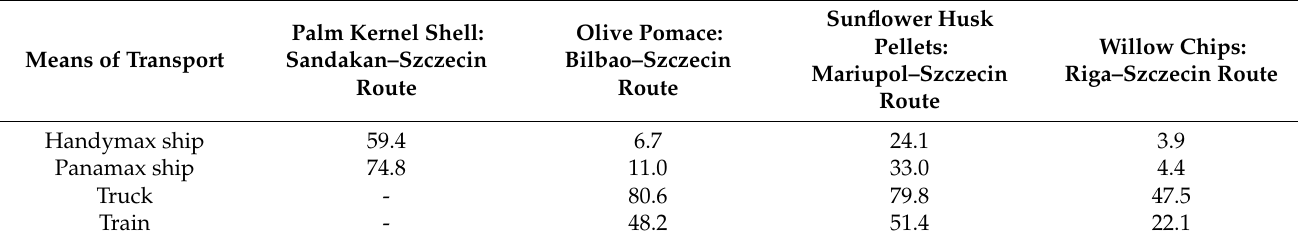
Table 5. CO 2 emissions per ton of biomass in the analyzed transport